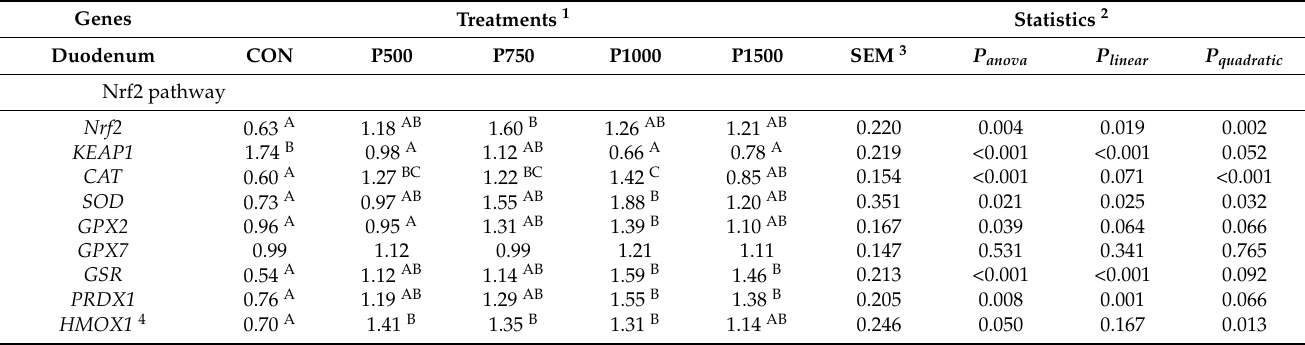
Table 7. Relative expression of Nrf2 pathway genes and heat shock response-related genes in the layers’ duodenum at the 12th week of the